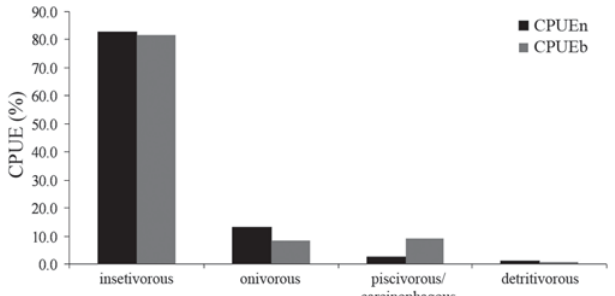
Fig. 4. Relative catch per unit effort (CPUE) in number (CPUEn) and biomass (CPUEb) of trophic guilds of the fish community of the Nova Avanhandava Reservoir.